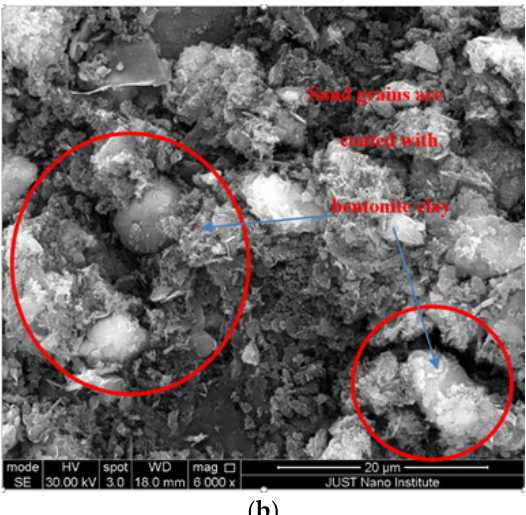
Figure 5. SEM images of stabilized sand with bentonite clay–water slurry. ( a ) SEM image of a stabilized sand mass surface (20,000 mag). ( b ) SEM image for the middle part of stabilized sand (6000 mag).